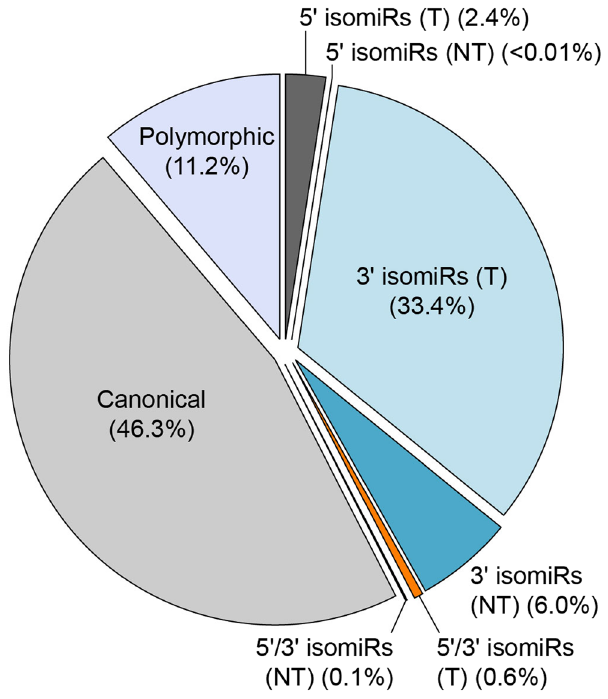
Figure 4. IsomiR distribution. The figure shows the distribution of the different types of isomiRs calculated on the total of mapped reads from all samples. The canonical form was predominant (46.3%), while the most frequent isomiR types were the templated (T) and non-templated (NT) 3 ′ isomiRs and the polymorphic